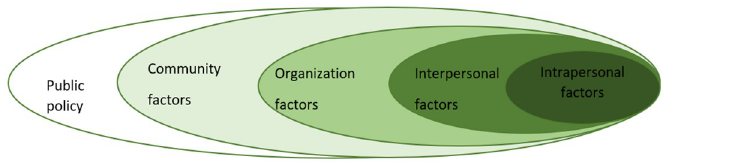
Fig 1. Social ecological Model (modified from McLeroy et al, 1988